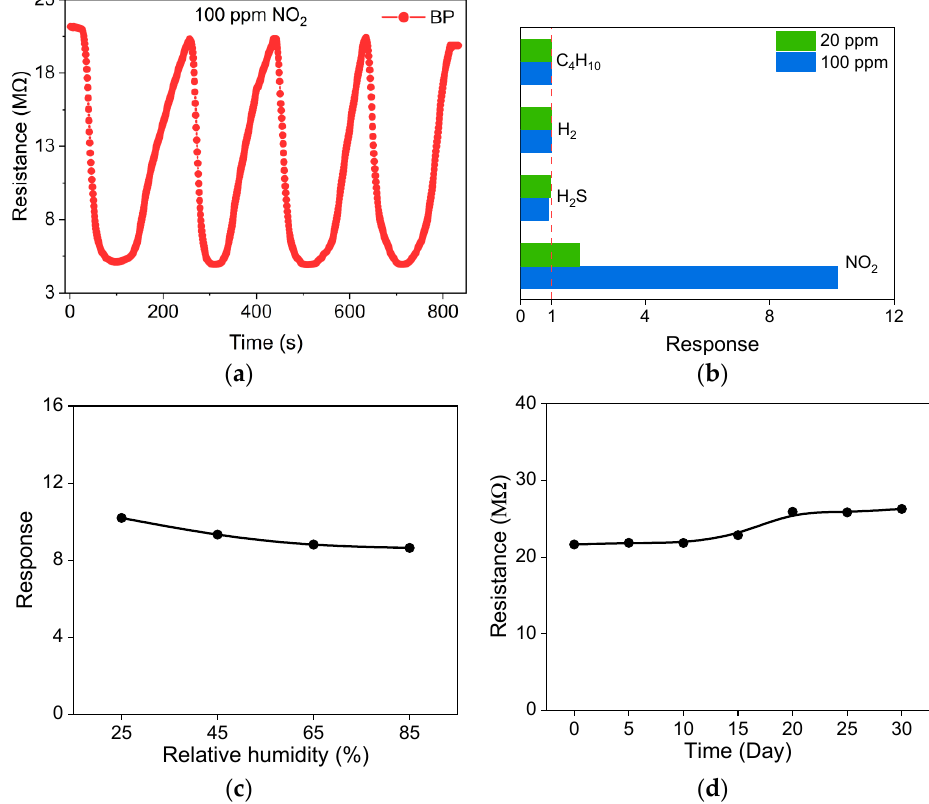
Figure 8. The repeatability, selectivity and stability evaluation of BP thin films deposited at 350 °C for 30 min: ( a ) Repeatability test; ( b ) Selectivity test; ( c ) RH dependence; ( d ) Resistance stability over time. Table 1. Comparison of NO 2 sensing performances of the BP-based gas sensors.